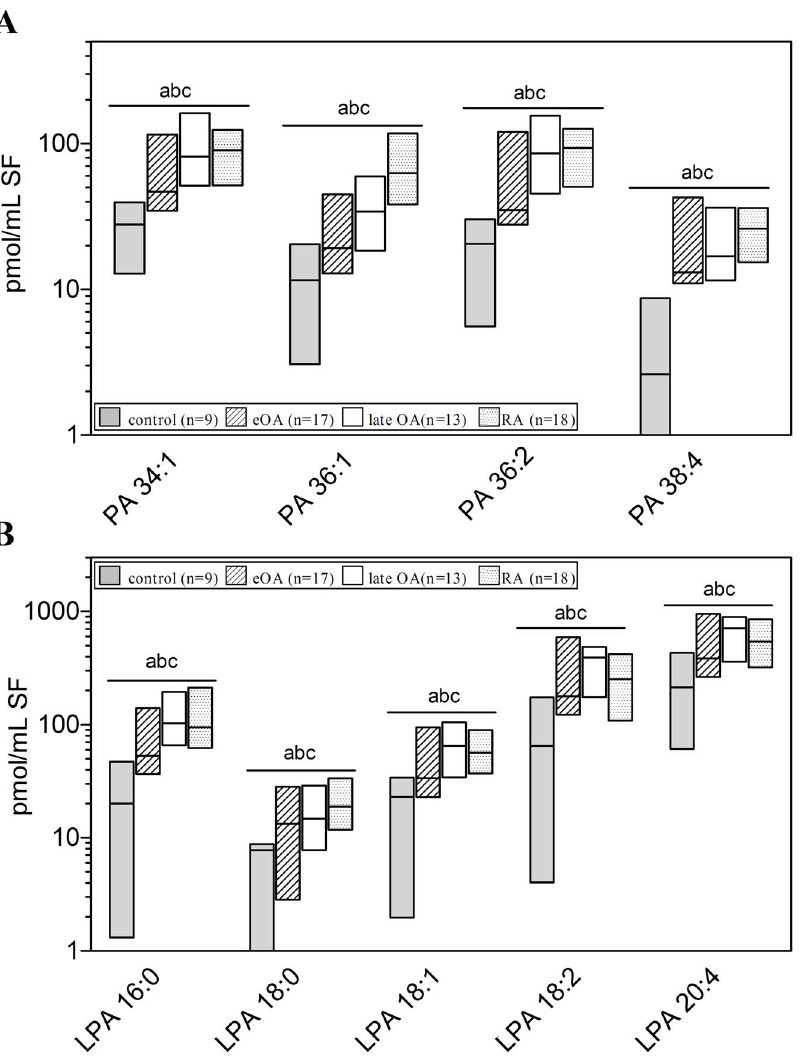
Figure 5. Concentrations of phosphatidic acid (PA) and lysophosphatidic acid (LPA) species in human knee synovial fluid. Synovial fluid was obtained from donors serving as controls and from patients with early osteoarthritis (eOA), late OA (lOA), and rheumatoid arthritis (RA). PA and LPA species were determined liquid chromatography coupled with tandem mass spectrometry as outlined in Material and Methods . Species annotation is based on the notion that only ester bonds are present. Values are presented as median and interquartile range. Significance was considered in the following way: a: p # 0.05: control vs eOA; b: p # 0.05: control vs lOA; and c: p # 0.05: control vs RA. ( A ): PA species, ( B ): LPA species. PA- phosphatidic acid, LPA- lysophosphatidic acid.